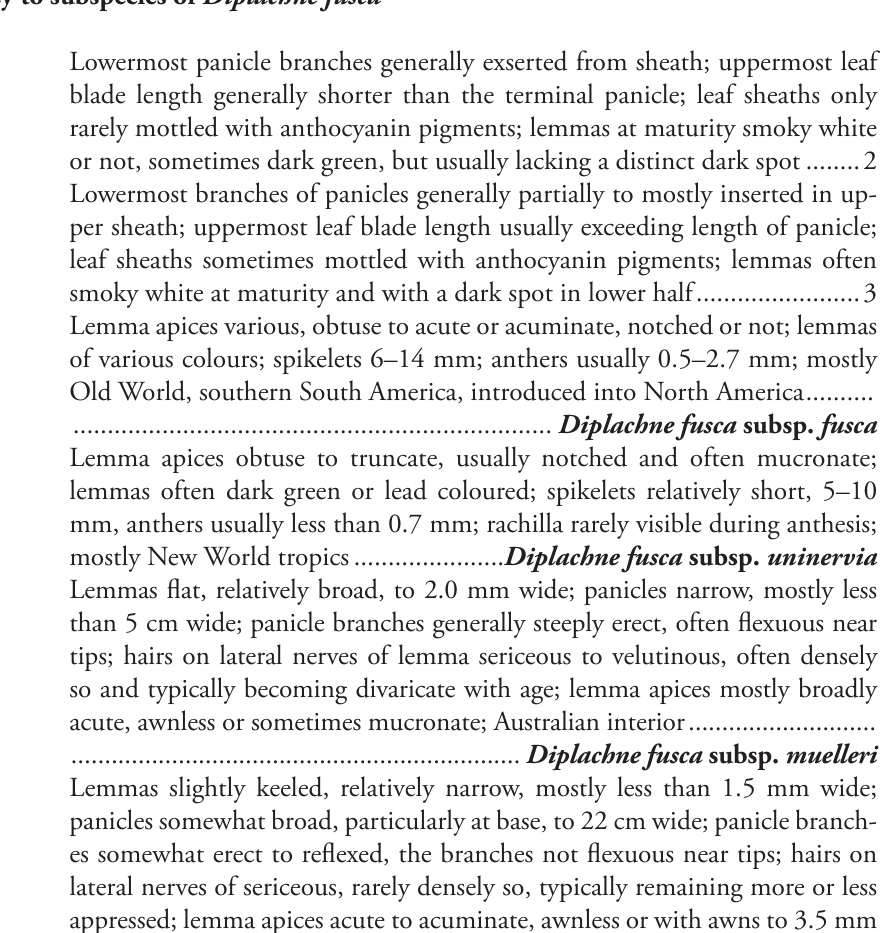
long; mostly New World ...................... Diplachne fusca subsp. fascicularis